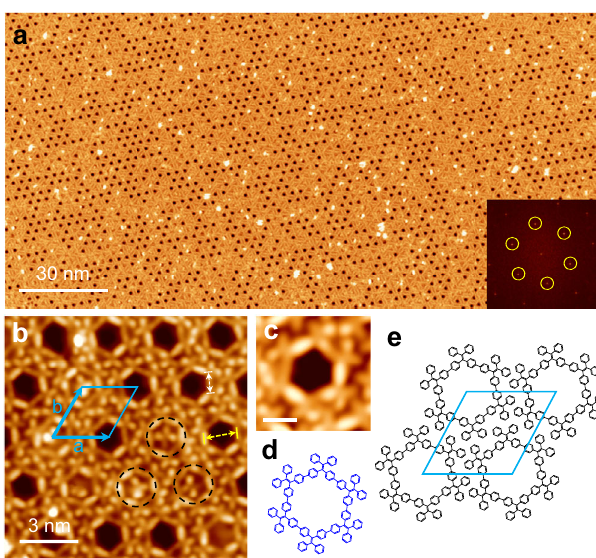
Fig. 2 Six-membered TPE macrocycles (M6) formed on Ag(111). a Large- scale STM image (200 nm × 100 nm; − 1.5 V, 20 pA) of the 2D crystalline monolayer made of six-membered macrocycles (M6). Inset: FFT pattern. b Zoom in STM image ( − 1.0 V, 100 pA) of the M6 2D crystal. The blue rhomb denotes the unit cell. The edge (white arrow) and the inner diameter (yellow arrow) of the hexagon are 0.98 ± 0.04 nm and 1.69 ± 0.03 nm, respectively. Dashed black circles highlight inclusion of TPE monomers in the macrocycle cavities. c , d High-resolution STM image (0.2 V, 100 pA) and chemical model of M6. Scale bar: 1 nm. e Schematic model of the M6 2D crystal.